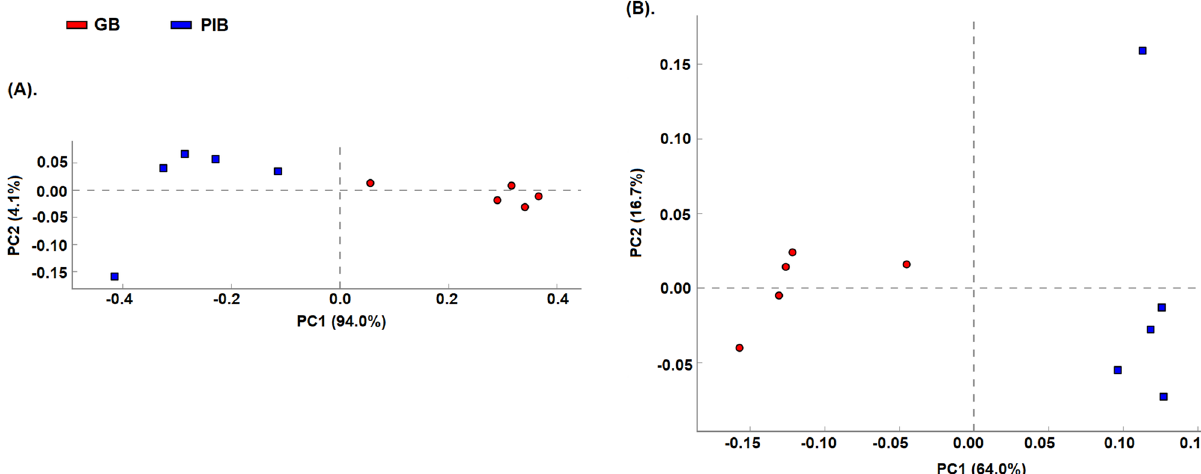
Figure 2. Principal component analysis (PCA) plot of the taxonomical profiles of GB and PIB groups at ( A ) genus, and ( B ) species levels. The different color reflects the fiber type, and each dot represents an individual sample. In the axes legends, the percent variability explained by PC1 and PC2 is provided in